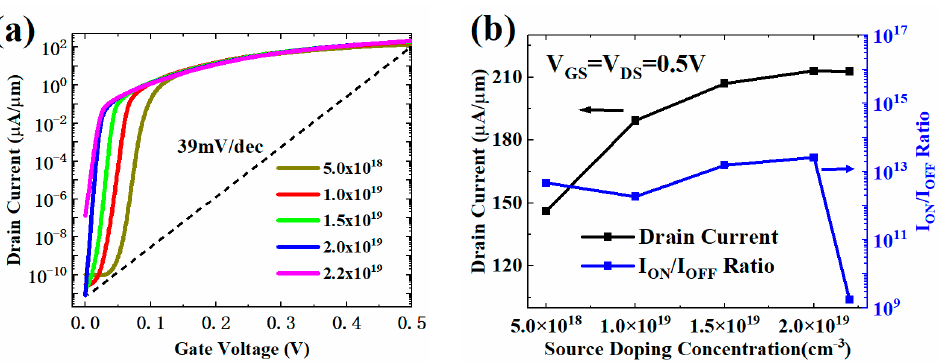
Figure 4. ( a ) Transfer characteristic and ( b ) I ON and I ON /I OFF with different N S values.